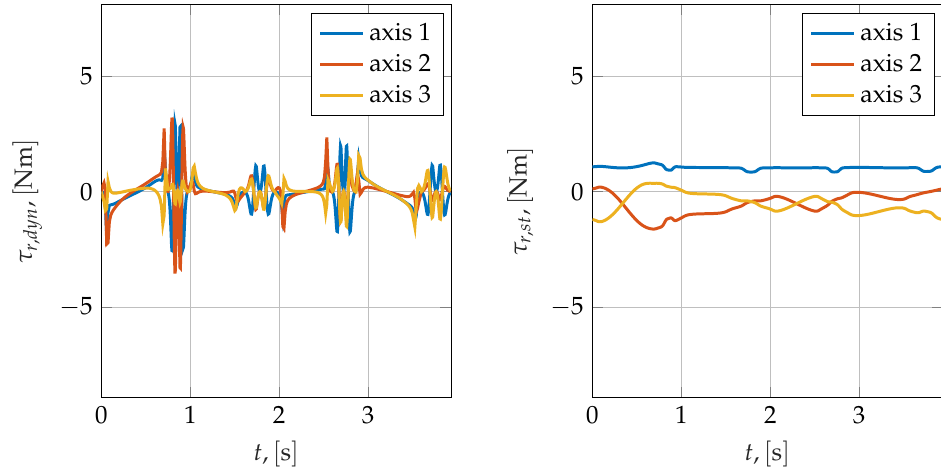
Figure 11. Dynamic and static torques at the actuated pulleys, payload 1.